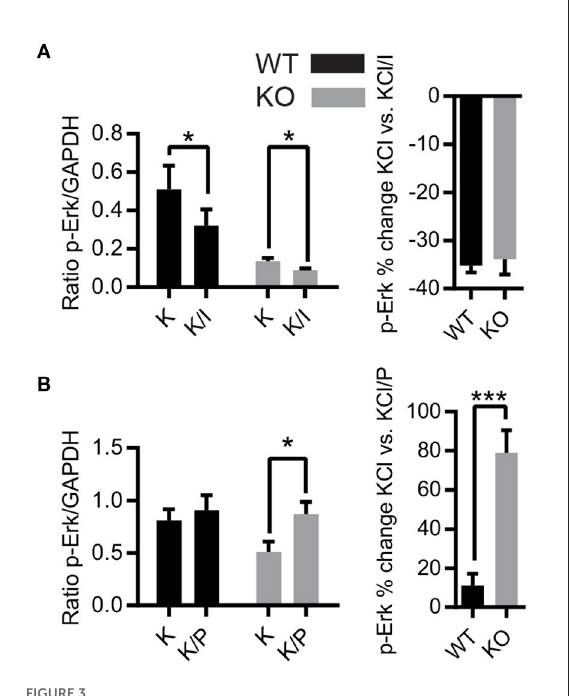
FIGURE3 Activity-dependent phosphorylation of Erk1/2 is differentially regulated by NMDAR subunits in ZnT3KO hippocampus. (A) Treatment with ifenprodil, an antagonist of the NMDAR NR2B subunit, showed a decrease in activity-dependent Erk1/2 phosphorylation with a similar percent decrease in both WT and ZnT3KO mice. (B) The activity-dependent phosphorylation of Erk1/2 is increased by incubation with the NR2A antagonist PEAQX, with a significant percent increase in ZnT3KO. WT, wild type; KO, ZnT3KO; ifenprodil, WT, n = 4 KO, n = 6; PEAQX, WT and KO, n = 5; K, 10-min incubation in 20mM KCl; K/I, 10-min co-incubation with 20mM KCl and 50 µ M ifenprodil: K/P, 30-min incubation with 0.5 µ M PEAQX followed by 10-min co-incubation with 0.5 µ M PEAQX/20mM KCl; * p < 0.05, *** p < 0.0005; values expressed as normalized densitometry relative to GAPDH. Data were analyzed by two-tailed unpaired t -test. Error bars indicate the mean ±